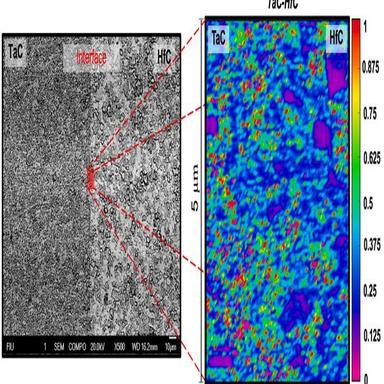
Surface SEM micrograph (left) and normalized elastic modulus mapping (right) for TaC-HfC joined ceramic.